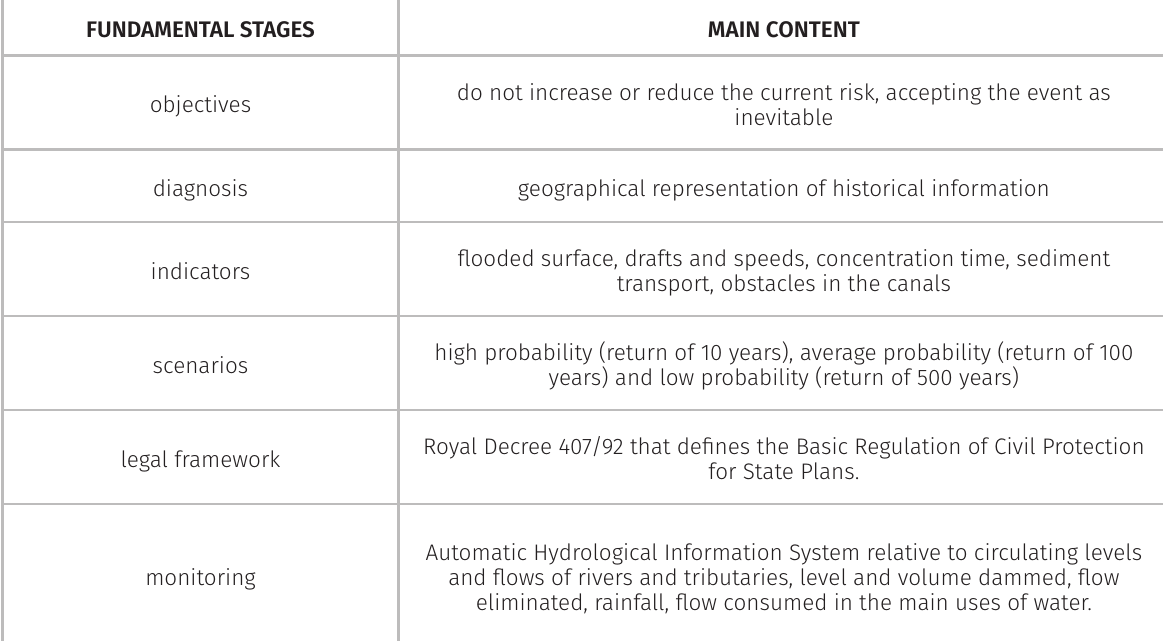
Table I. Summary of the main procedures for the preparation of the Flood Risk Management Plan (source: prepared by the